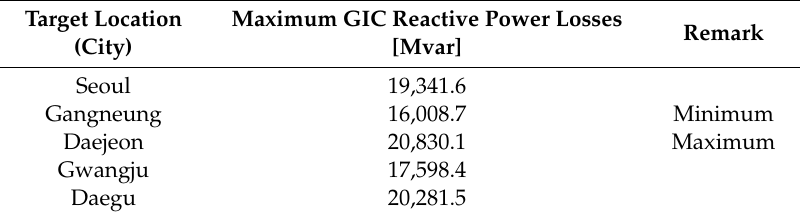
Table 3. Maximum values of the geomagnetically-induced current (GIC) reactive power losses for E3 HEMP events over different target locations.